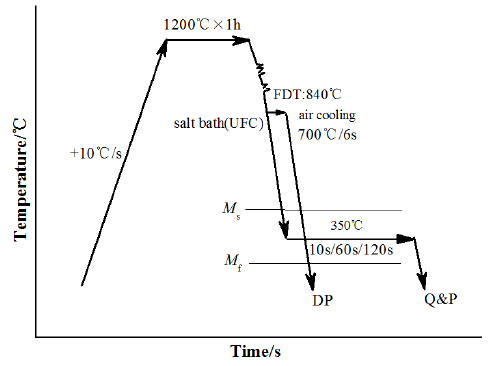
Figure 2. Process flow chart of the test steel.